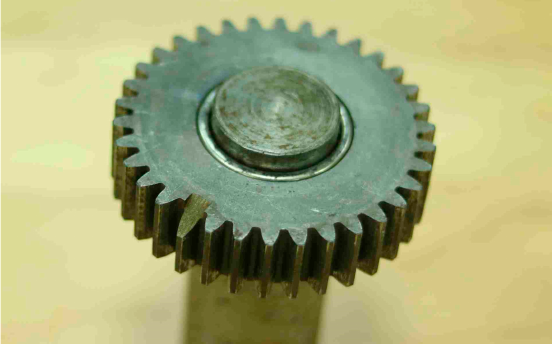
Figure 17. Planet gear with tooth broken